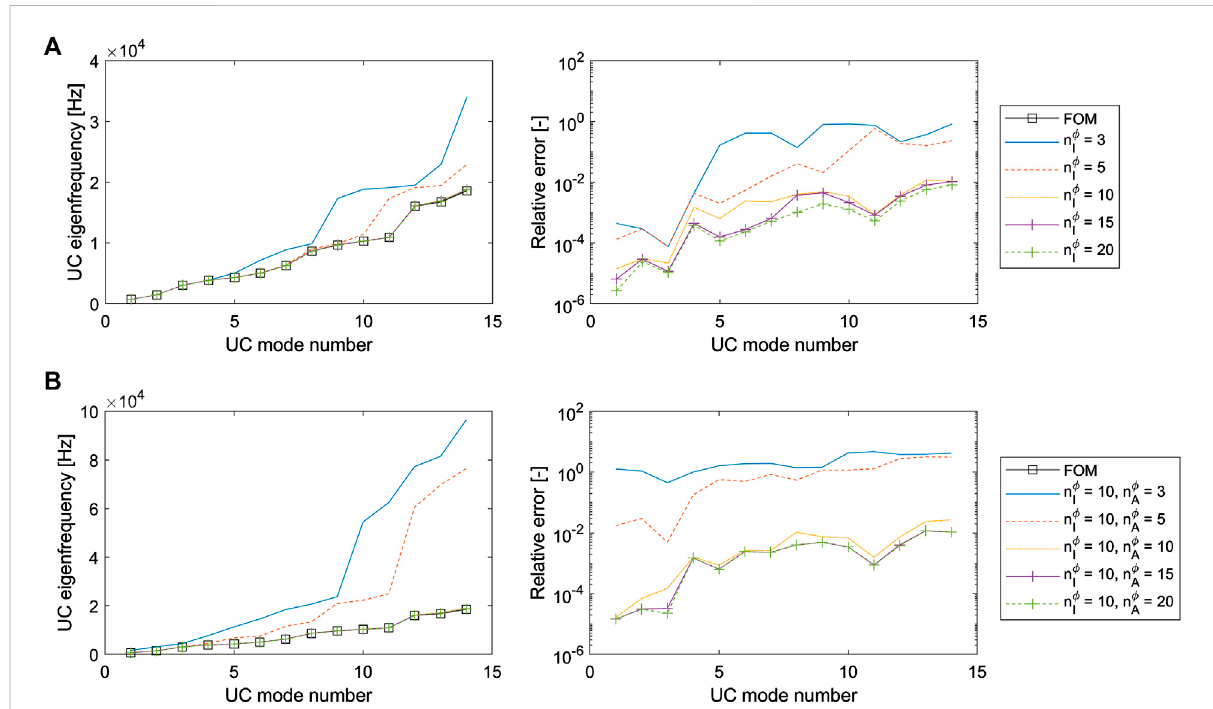
FIGURE 2 (A) Eigenfrequencies(left)andrelativeerroroftheeigenfrequencies(right)computedfortheBMSreducedfreeUC,consideringdifferent n ϕ I . (B) Eigenfrequencies (left) and relative error of the eigenfrequencies (right) computed for the GBMS reduced free UC, considering n ϕ I (cid:2) 10 and different n ϕ A